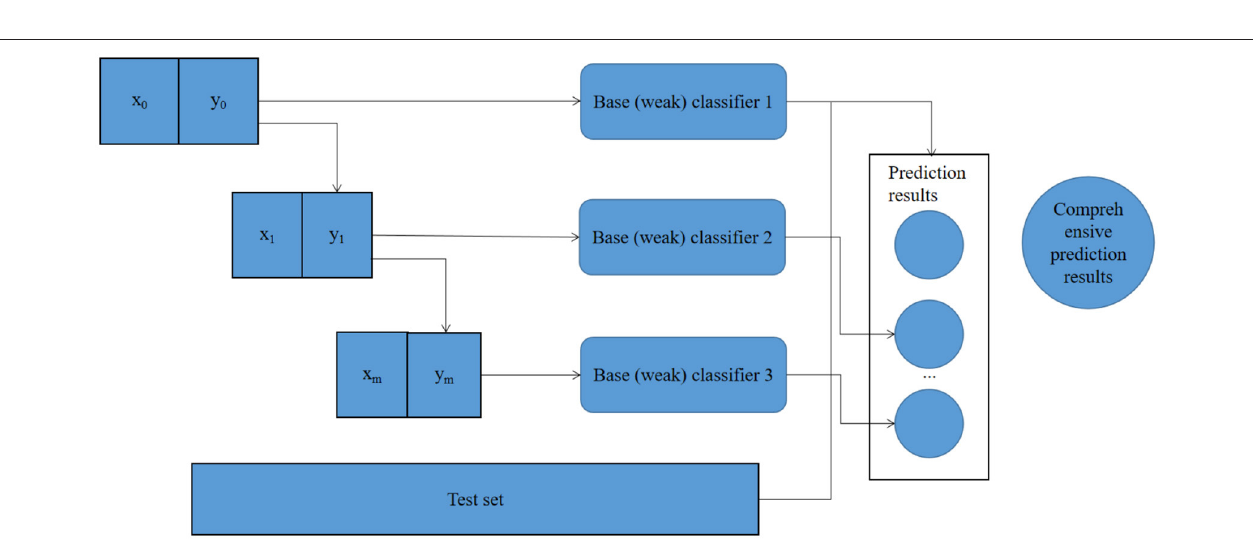
FIGURE 1 | Schematic diagram of the structure of infant intelligent health diagnosis and intelligence development.